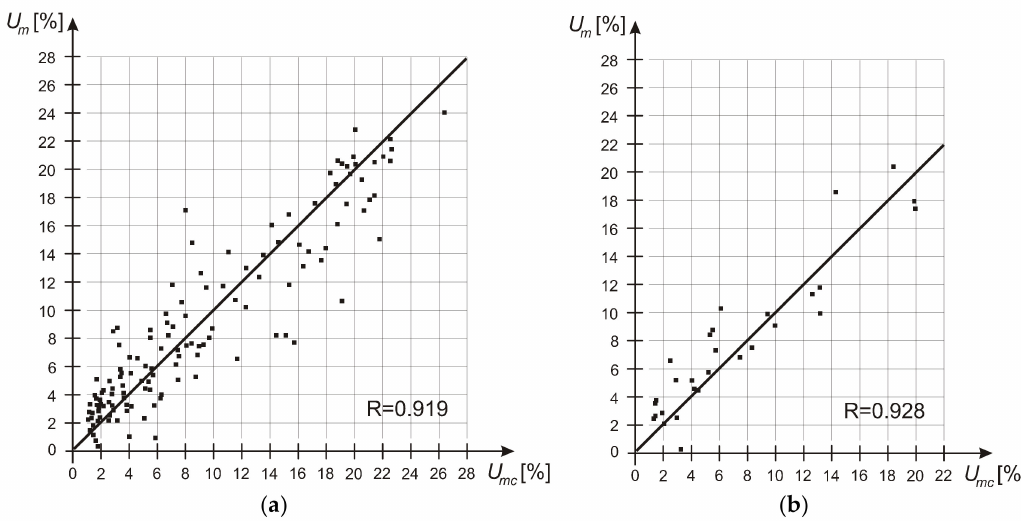
Figure 3. The relationship between the mass humidity, obtained using the gravimetric method, and humidity, which was identified by the network for the process of: ( a ) learning and ( b ) testing (based on the results presented in